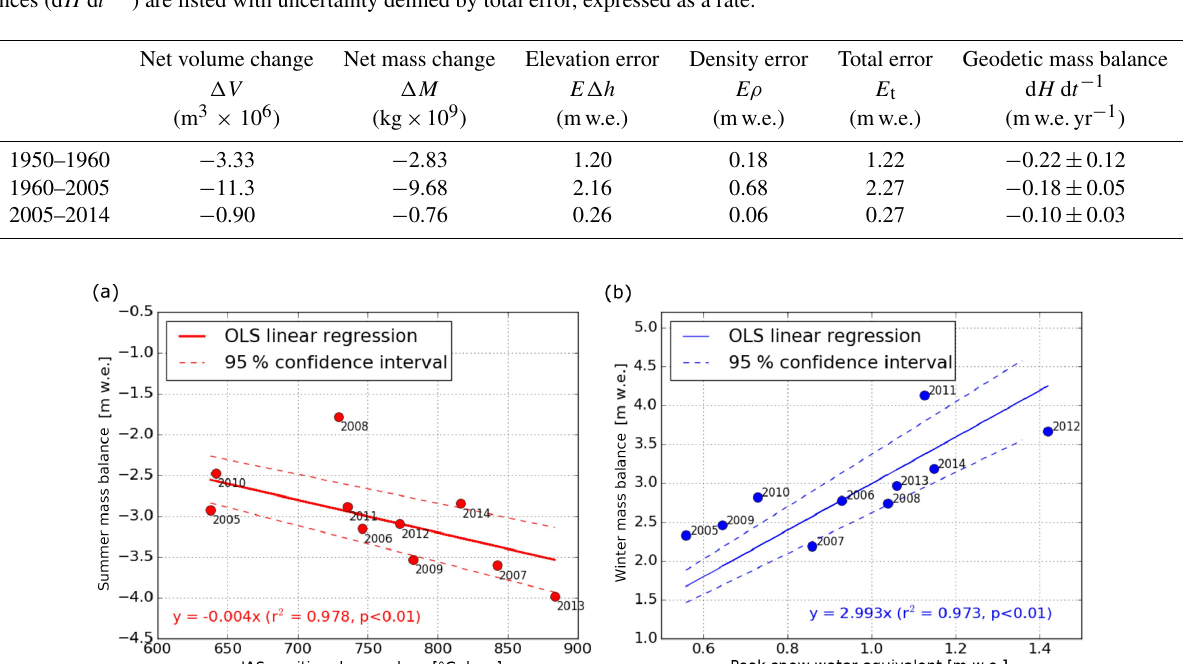
Table 3. Geodetic mass balance results. Net changes in volume ( (cid:49)V ) and mass ( (cid:49)M ) on Sperry Glacier from 1950 to 1960, 1960 to 2005, and 2005 to 2014 are listed. Uncertainties due to elevation error ( E(cid:49)h ) and density ( Eρ ) are listed, as are total errors ( E t ). Geodetic mass